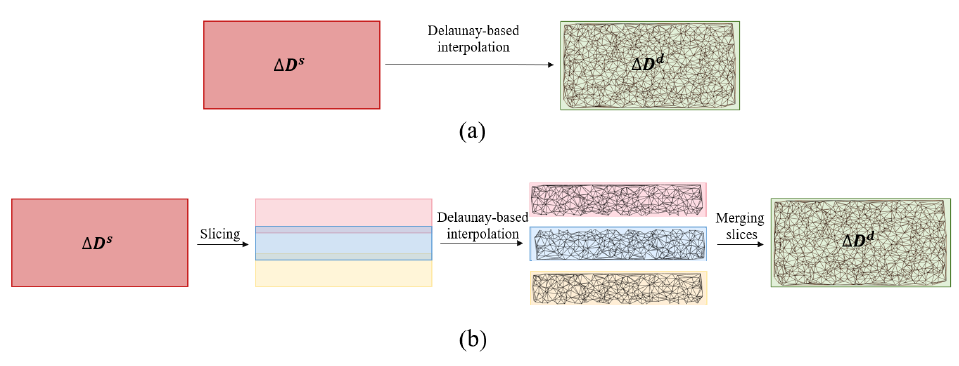
Figure 4. ( a ) Delaunay correction (DC), and ( b ) sliced Delaunay correction (SDC). In DC, the Delaunay-based interpolation is conducted on the whole sparse correction map. While in SDC, each SD map is first divided into three slices with overlap, then the correction value ( ∆ D s ) is interpo- lated using Delaunay-based interpolation in each of them, independently. In the overlapped areas, the average of the values from the two slices is